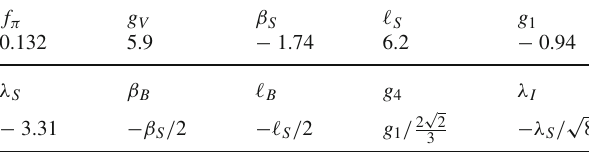
Table 2 The parameters and coupling constants. The λ , λ S , I and f π are in the unit of GeV − 1 . Others are in the unit of